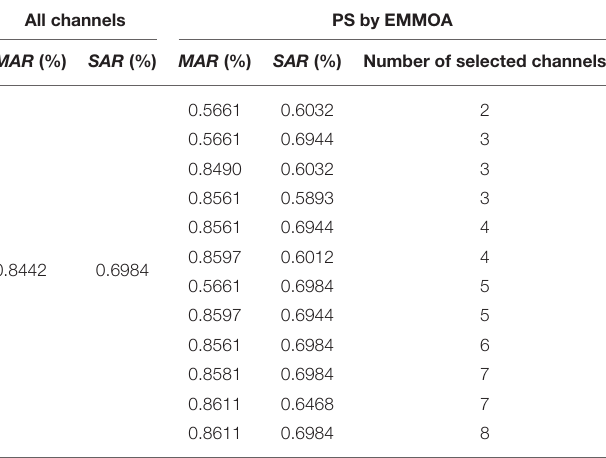
TABLE 3 | Average classification accuracies for all subjects by using all channels and the pareto-optimal set obtained by EMMOA for all subjects. All channels